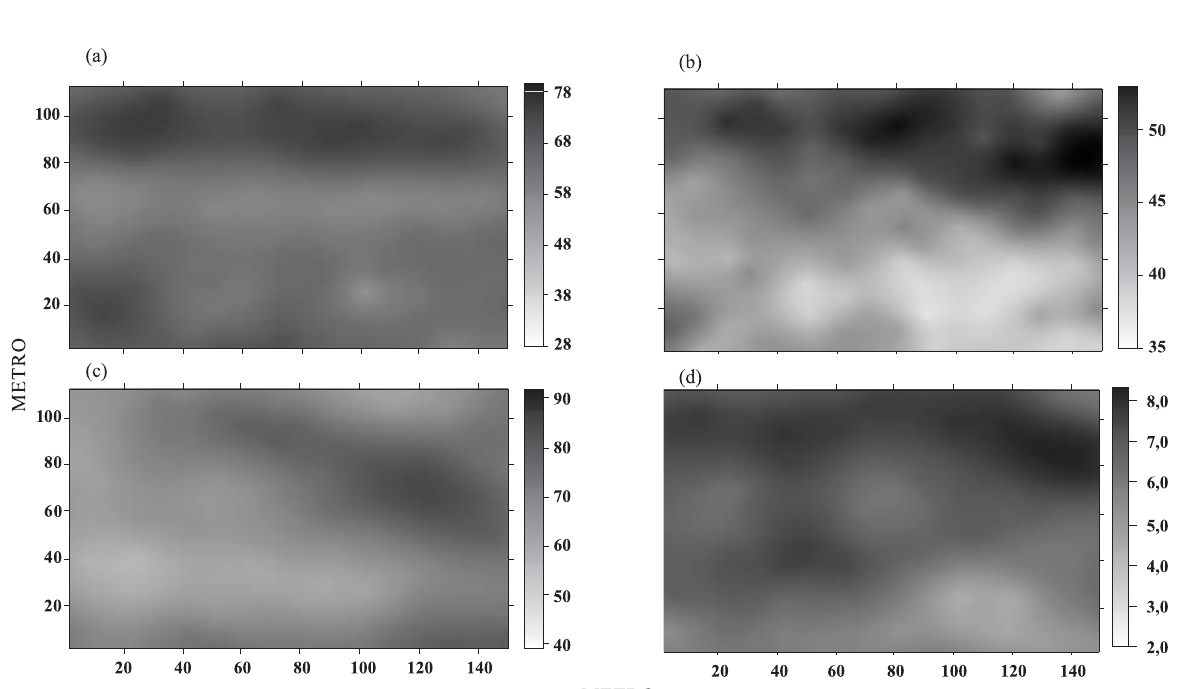
Figura 7. Mapas de variabilidade das variáveis Fe (mg dm -3 ) (a), MO (g dm -3 ) (b), Mn (mg dm -3 ) (c) e H + Al (cmol dm -3 c